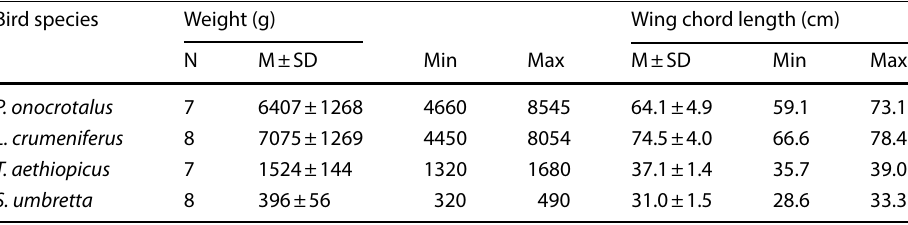
Table 1 Weight and wing chord length of bird